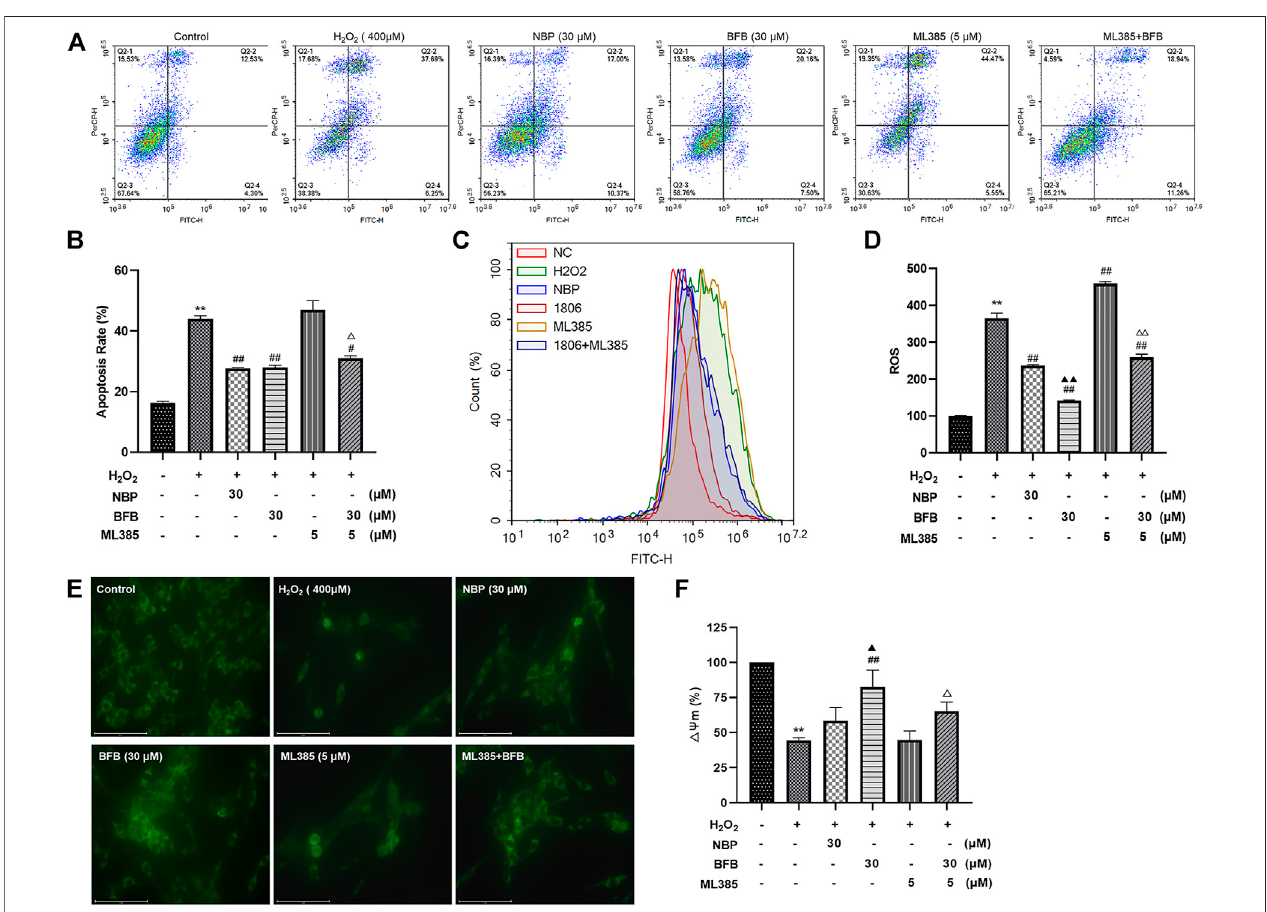
FIGURE7| Nrf2suppressionmitigatedBFB ’ sinhibitiononoxidativestress.5 μ mML385pretreatmentofPC12cellsfora0.5-hperiod,followedbyH 2 O 2 (400 μ m) stimulation with/without BFB (30 μ m) or NBP (30 μ m) (A,B) FCM on apoptotic rate using Annexin V/PI staining (C,D) FCM on ROS production using DCFH-DA (E) Typicalimagespresentingmitochondrialstainingunderdiverseconditionsbyusing fl uorescencemicroscopy(scalebar=100 µm) (F) Bargraphpresenting fl uorescence intensity, which indicated MMP, by using fl uorescence microplate reader. Data were represented by mean ± SD from 3 separate assays. * p < 0.05, ** p < 0.01, versus Control, # p < 0.05, ## p < 0.01, versus H 2 O 2 group. ▲ p < 0.05, ▲▲ p < 0.01, versus NBP group. △ p < 0.05, △△ p < 0.01, versus ML385